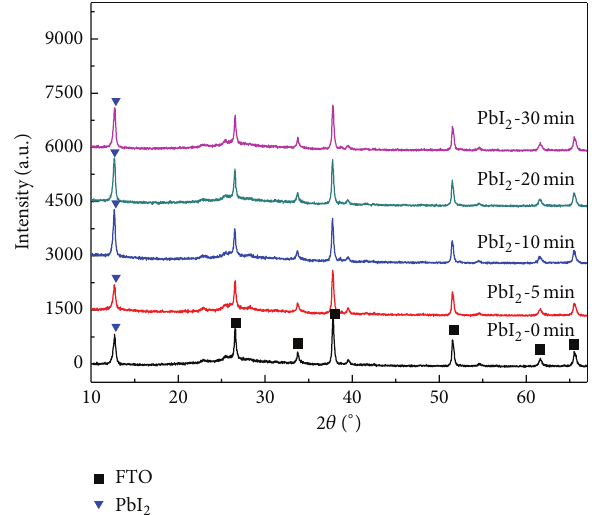
Figure 8: XRD patterns of PbI 2 films, which were dried for different time.